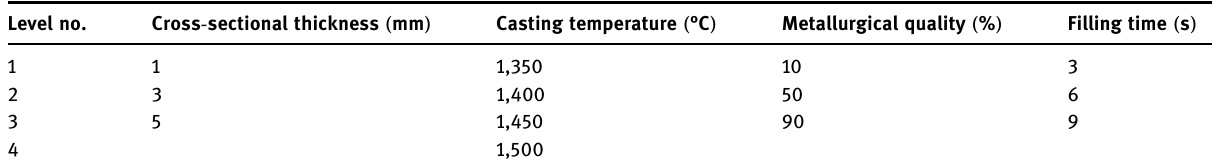
Table 1: Experimental parameters and levels Level no.